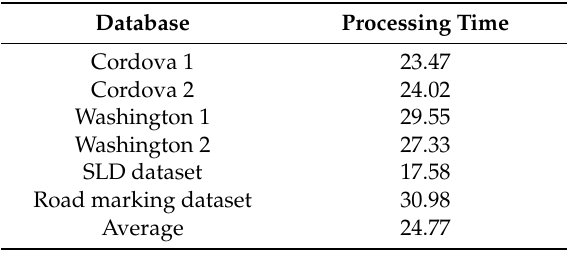
Table 8. Processing time per each frame by our method (unit: milliseconds).